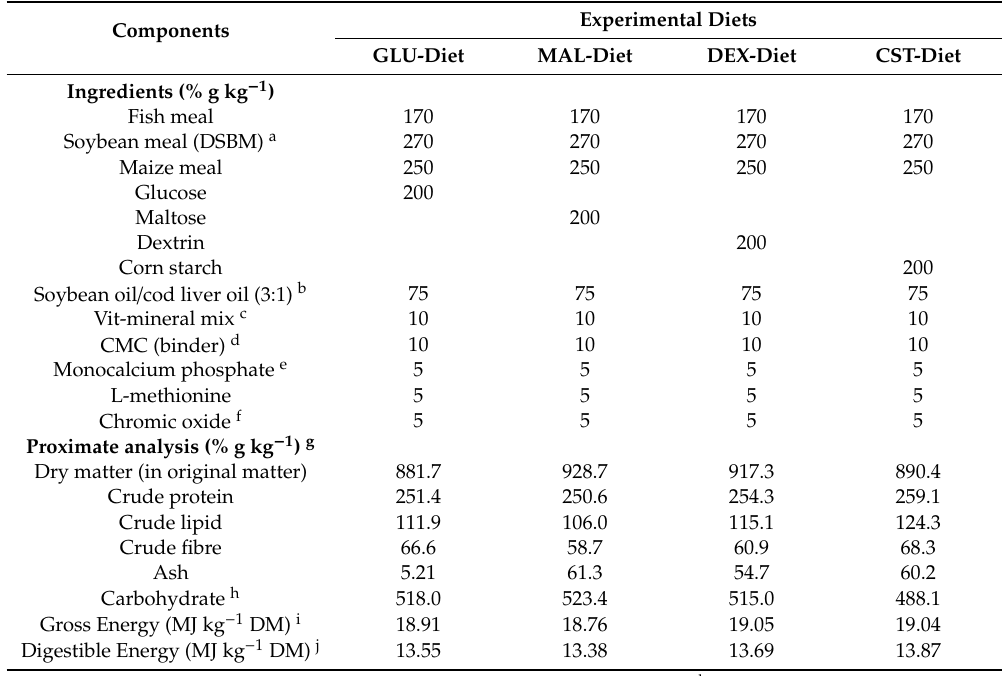
Table 1. Ingredients and proximate composition of the experimental diets (% dry matter).